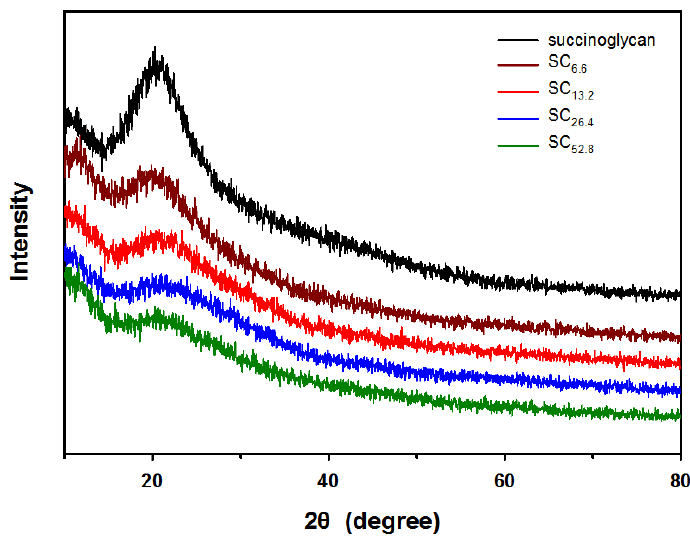
Figure 5. Changes in X-ray diffraction (XRD) patterns of succinoglycan due to hydrogel formation by addition of Cr 3+ .